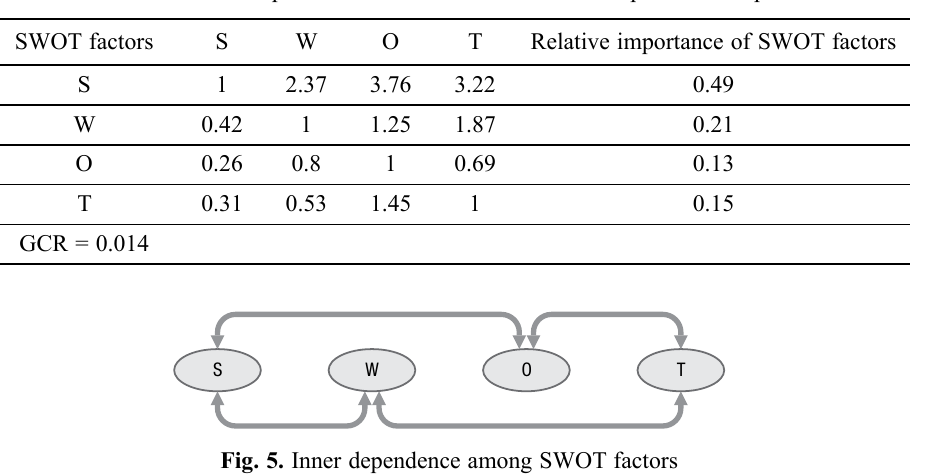
Table 3. Pairwise comparison of SWOT factors with assumption of independence